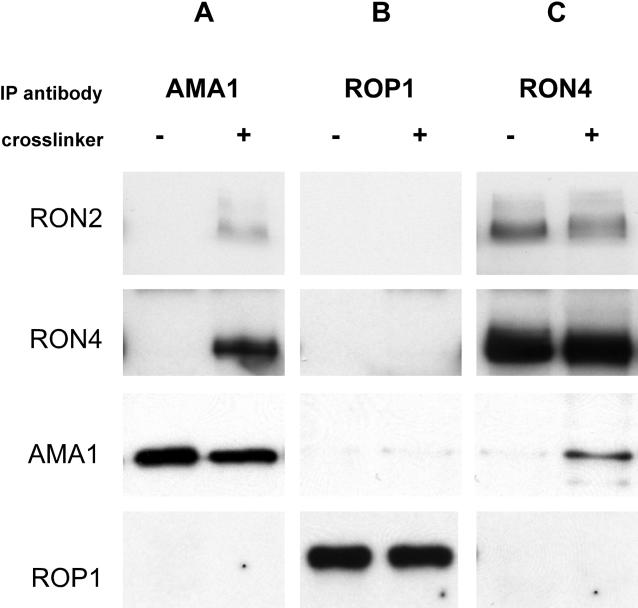
Immunoprecipitation from Lysates of Parasites Subjected to Chemical Cross-Linking in Live CulturesTachyzoites were allowed to synchronously invade fibroblast monolayers in the absence (−) or presence (+) of the homobifunctional cross-linking agent DTSSP. Invasion and cross-linking were allowed to proceed for 15 min, then the reaction was quenched and invasion stopped. Harvested parasites were extracted in 1% SDS and heat denatured, and then processed for immunoprecipitation with antibodies to TgAMA1 (A), ROP1 (B), or RON4 (C). These immunoprecipitates were separated by reducing SDS-PAGE and analyzed by immunoblotting to determine the presence or absence of RON2, RON4, TgAMA1, or ROP1 in the co-precipitating material.